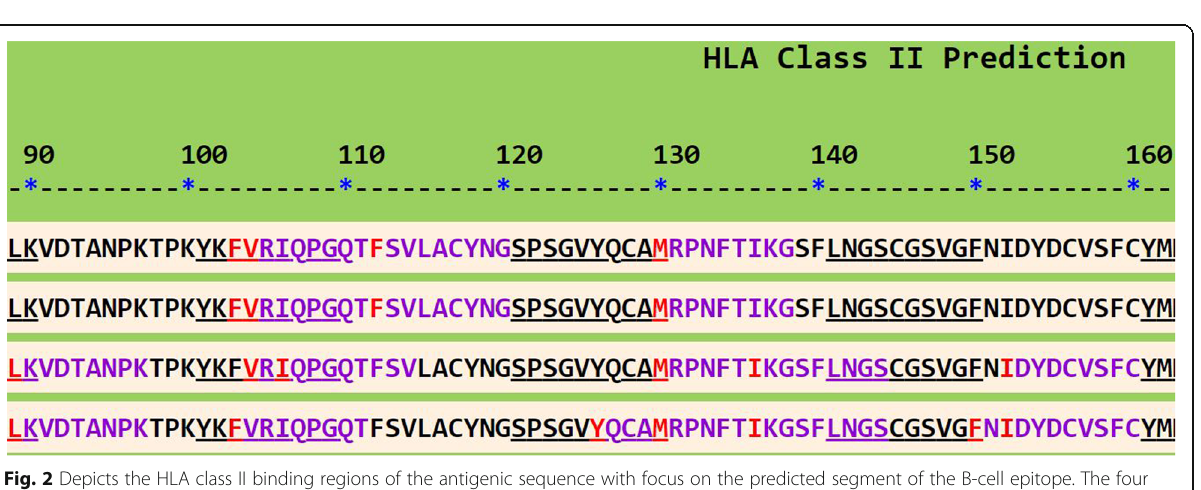
Fig. 2 Depicts the HLA class II binding regions of the antigenic sequence with focus on the predicted segment of the B-cell epitope. The four selected alleles are HLA-DRB1*0101, 0102, 0301 and 0305, from top to bottom respectively. The N-terminals of predicted binders are shown in red and all other residues in blue